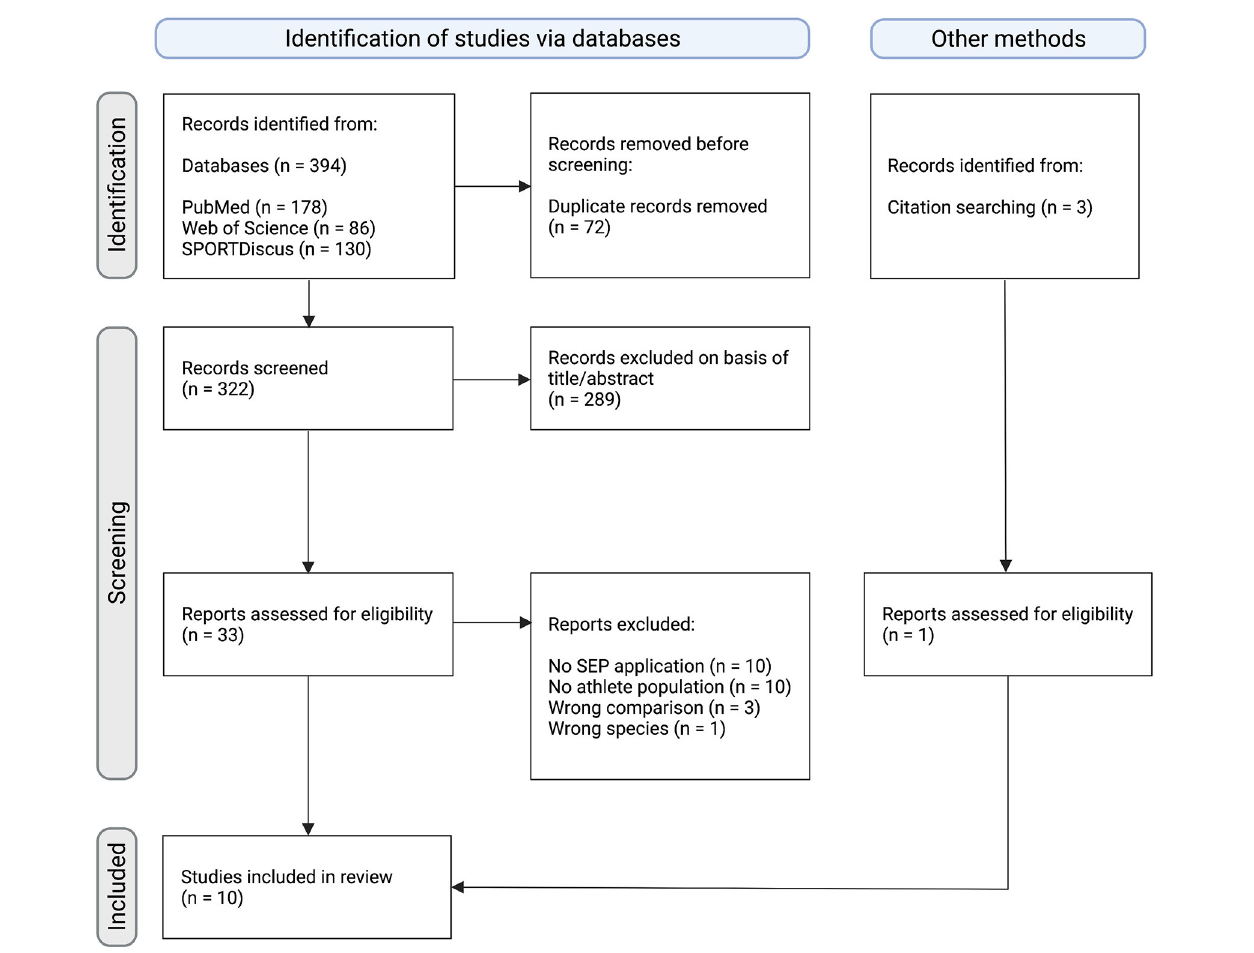
FIGURE 1 | Flow chart diagram depicting the study selection process. Initially, 397 records were identified of which 10 studies were deemed eligible within the scope of the present systematic review. This figure was created with